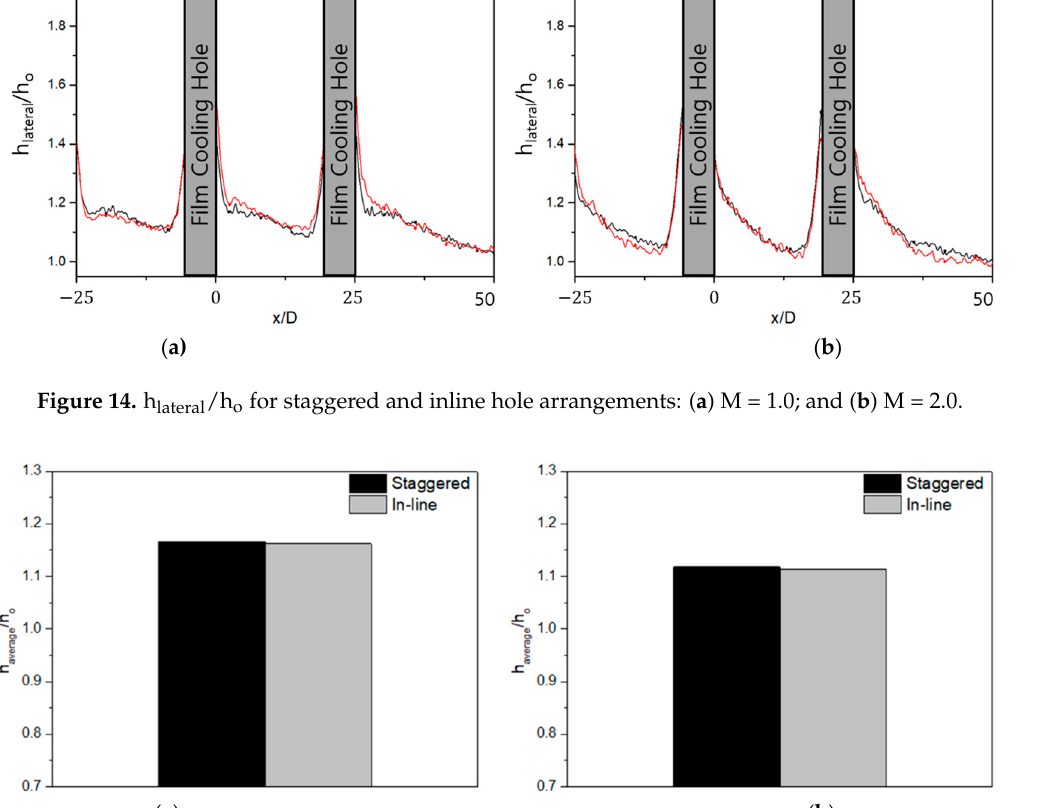
Figure 15. h average /h o for staggered and inline hole arrangements: ( a ) M = 1.0; and ( b ) M = 2.0.